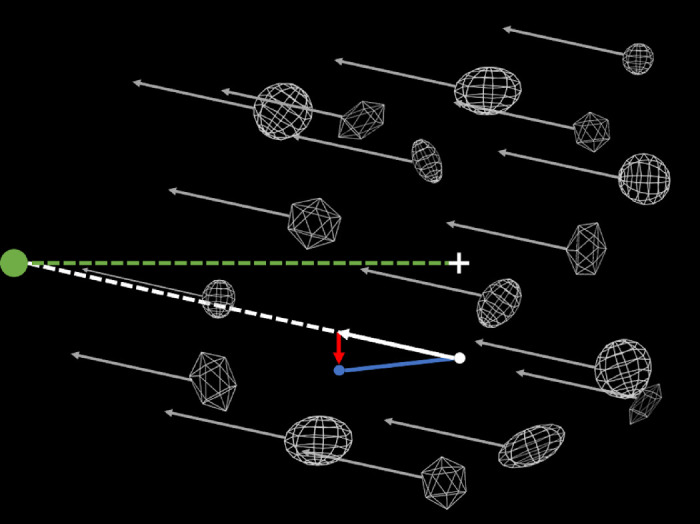
Simplified birds-eye view of the stimulus in Experiment 1 (not to scale). Green sphere indicates the position of the observer relative to the stimulus (not to scale). The green dotted line represents the direction of the observer's gaze to the white central fixation cross and therefore the center of the field of view. The gray arrows indicate the direction of movement of the scene toward the observer. The white sphere indicates the initial position of the probe dot at the same depth as the fixation cross. The probe moves with the scene (white arrow) but with an added rightward or leftward (depending on the trial) scene-relative motion (red line). The resulting motion of the probe (blue sphere) is indicated by the blue line.